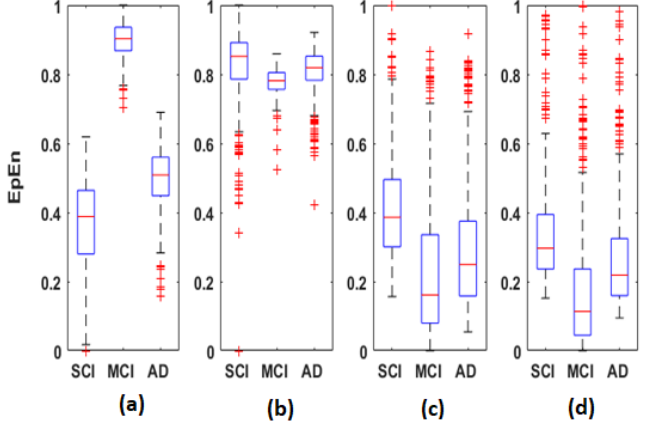
Figure 7. Boxplots of EpEn values averaged over all subjects of the SCI, MCI and AD groups on the ( a ) delta, ( b ) theta, ( c ) alpha and ( d ) beta bands.